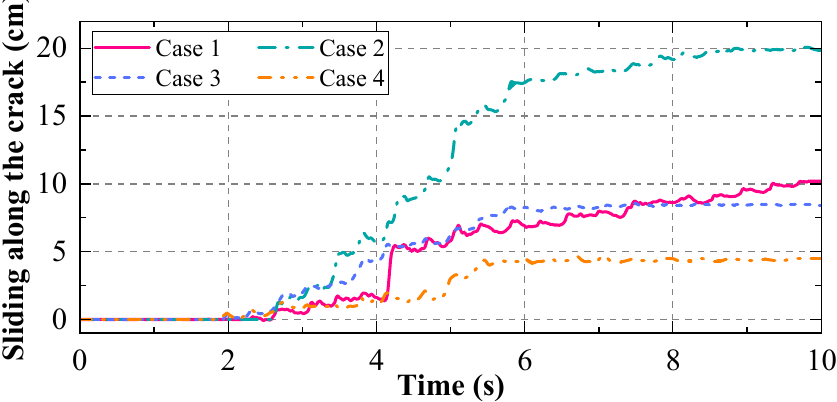
Figure 12. Sliding displacement histories of four cases. Figures 13 and 14 show the responses of the maximum and minimum principal stresses of the dam heel for four different cases. It is clear that the peak tensile stress decreases a weak layer is present. The numerical results also reveal that the peak tensile stress of the dam heel decreases as the position of the weak layer is lowered. The reason is that the stress of the dam heel is released after the failure of the weak layer occurs. Similarly, there is an obvious decline in the response of compressive stress when a weak layer is present. The rules correspond to those obtained by Gu et al. [3]. They found that the maximum and minimum stresses are only slightly decreased on the downstream surface of the dam when cold interfaces were present. From this perspective, the stress state is beneficial to the dam to some extent. According to the displacement and stress responses of the dam, it can be preliminarily inferred that the impact of the RCC layer on the seismic performance of the dam has both advantages and